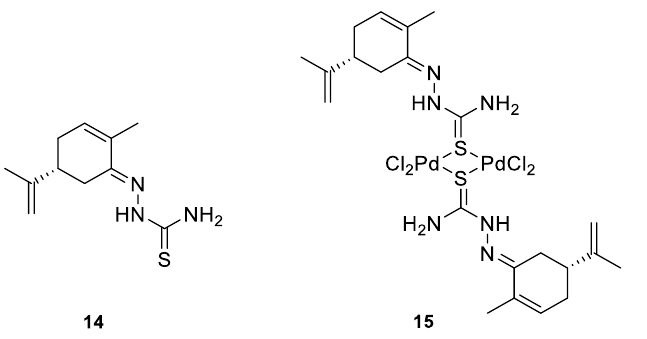
Figure 5. Carvone derivatives examined against tumor cell lines: HCT-116 (colon), OVCAR-8 (ovarian) and SF-295 (brain).